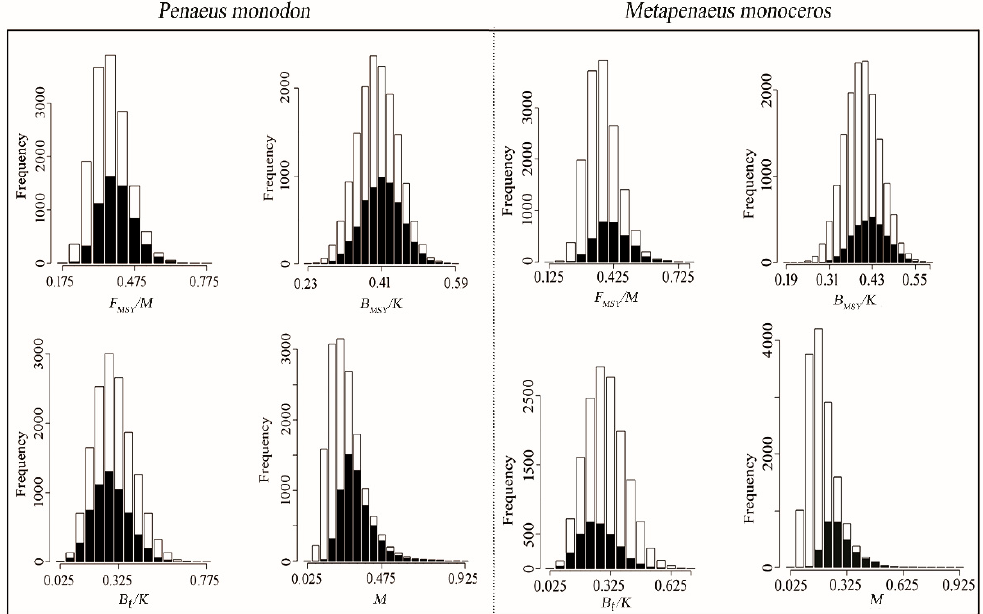
Figure 3. Input parameters distributions from accepted (black) and rejected (white) model runs.